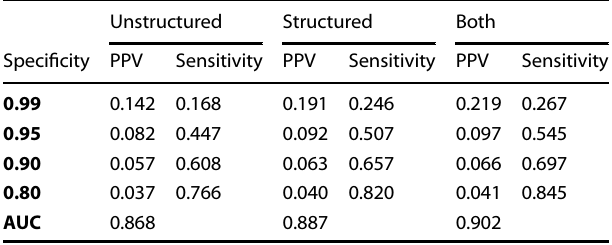
Table 3. Performance of BRF models on the test